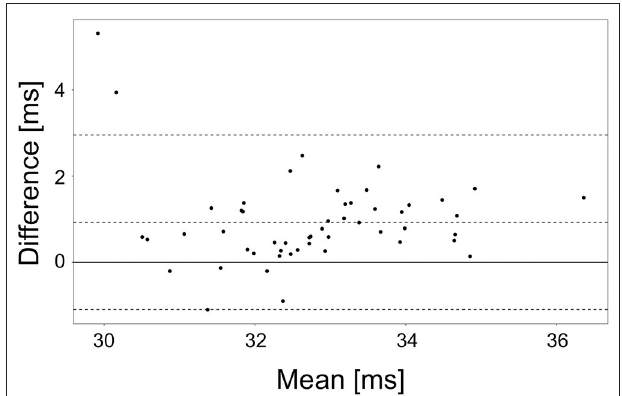
FIGURE 5 | Bland Altman plot of the agreement of the wT2 values obtained by the QMRTools software package and the presented software, for an unconstrained 17-echo EPG reconstruction. The bias and the 95% confidence intervals are depicted in the